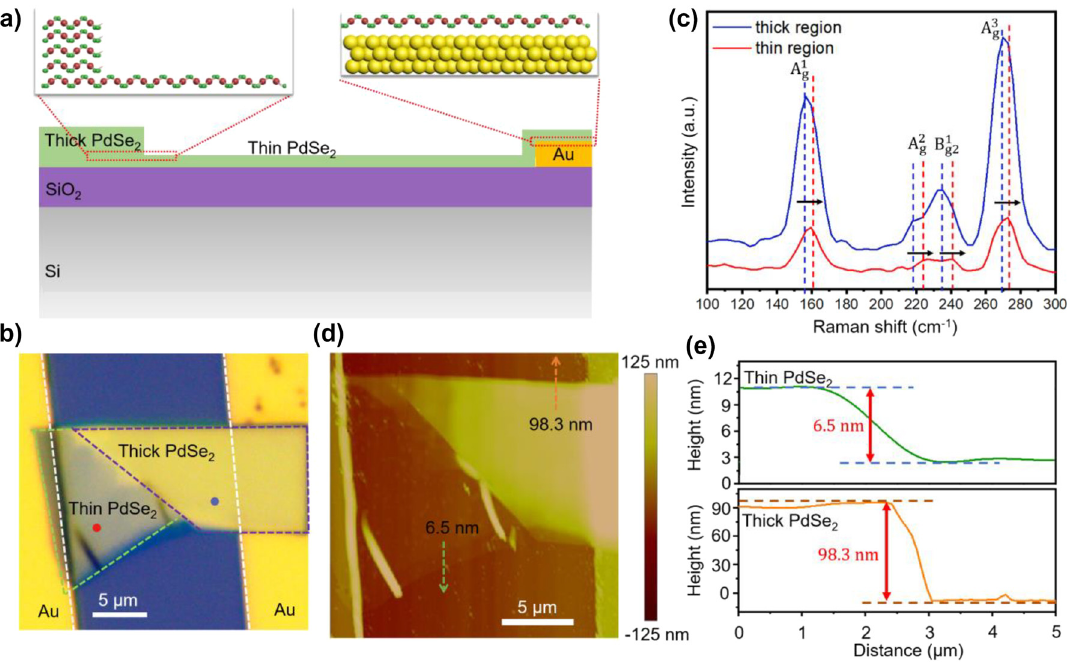
Figure 1: Structure characterization of the photodetector with asymmetric vdWs contacts. (a) The schematic diagram of a PdSe photodetector with asymmetric vdWs contacts. The scale bar is 5 μ m. (c) The Raman spectra of the PdSe (b) The optical image of the PdSe 2 measured at the blue and red points marked in (b). The thin and thick PdSe modes, which referred to a “blue-shift” labeled by the black arrows. (d) The AFM image of the photodetector with non-uniform thickness across the channel. The scale bar is 5 μ m. (e) The corresponding thickness measurements of the PdSe for the thin part and 98.3 nm for the thick part. The measurement directions are illustrated as the green and orange dotted arrows presented in (d).